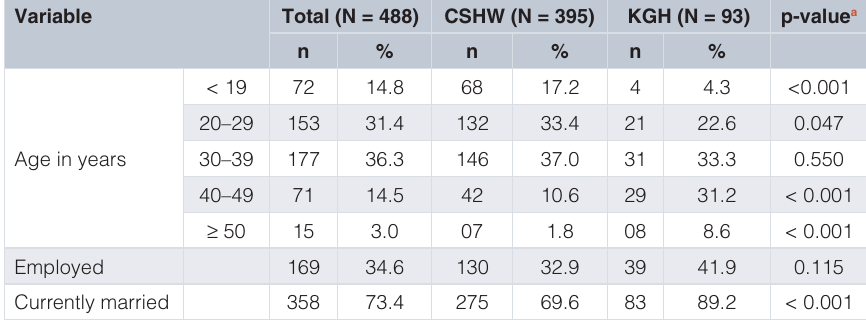
Table 1. Characteristics of women attending gender-based violence care center